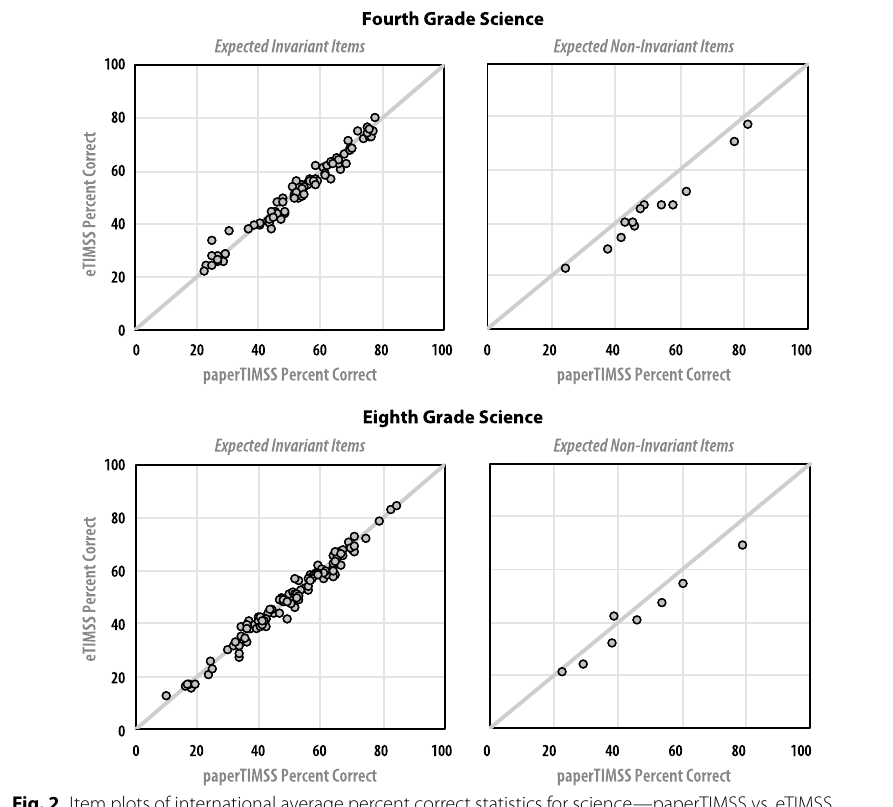
Fig. 2 Item plots of international average percent correct statistics for science—paperTIMSS vs. eTIMSS. Each data point represents a science trend item with x -axis the percent correct based on paperTIMSS data and y -axis percent correct based on eTIMSS data. Expected invariant items (left) were included in the analysis. Expected non - invariant items (right) were plotted as a means of comparison